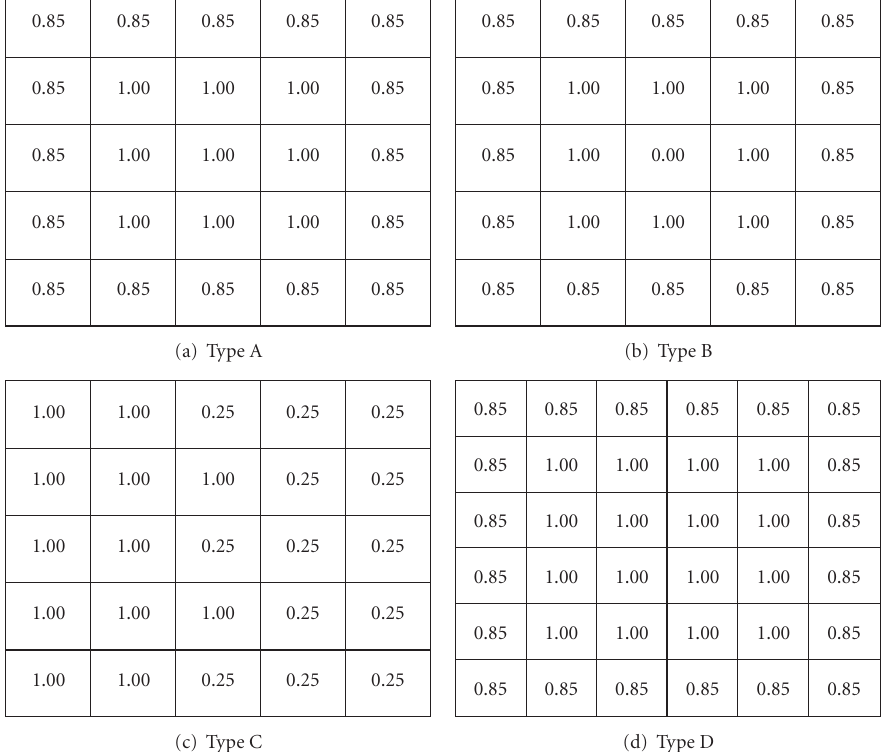
Figure 18: Radial power distribution [2].